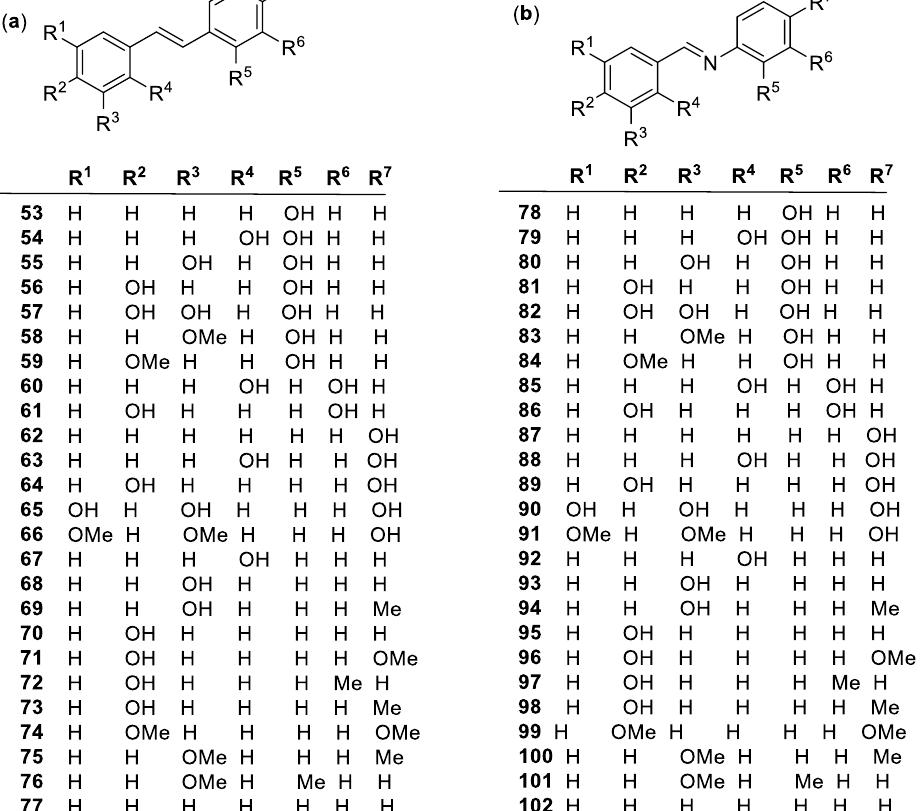
Figure 7. The structure of vitamin E-related antioxidants, including trolox a commonly applied reference compound.